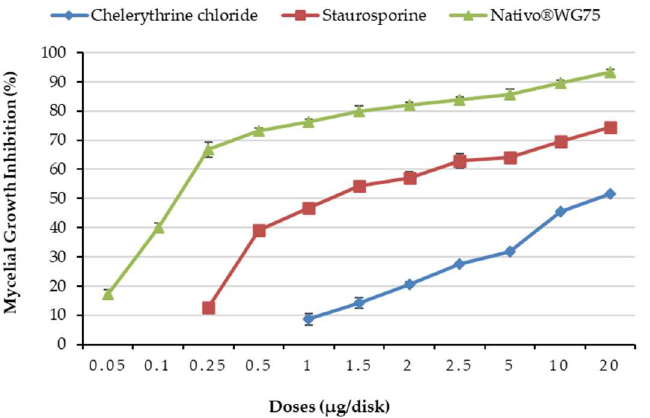
Figure 3. Inhibitory effects of chelerythrine chloride, staurosporine and the commercial fungicide, Nativo ® 75WG on mycelial growth of wheat blast fungus Magnaporthe oryzae Triticum (MoT) in potato dextrose agar media. The data are the mean ± standard errors of five replications for each concentration of the compound tested at 5% level based on the Tukey HSD (Honest Significance Difference) post-hoc statistic.